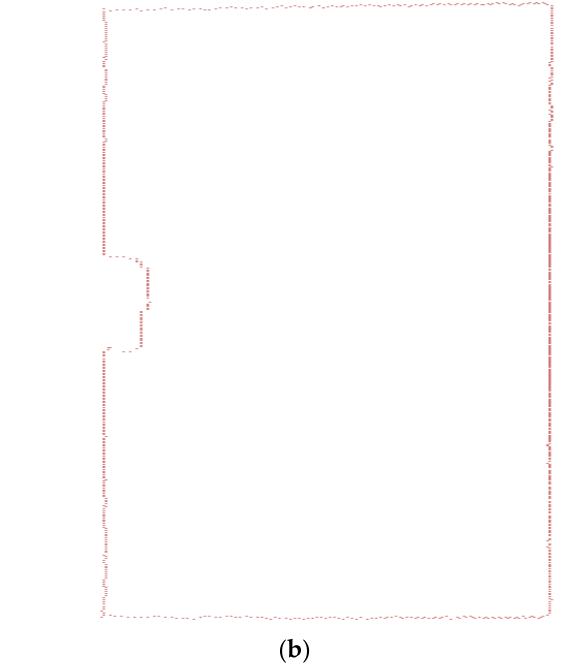
Figure 2. Boundary point extraction algorithm where ( a ) the point projected on the micro ‐ tangent plane is on the plane’s boundary and ( b ) is inside the plane.